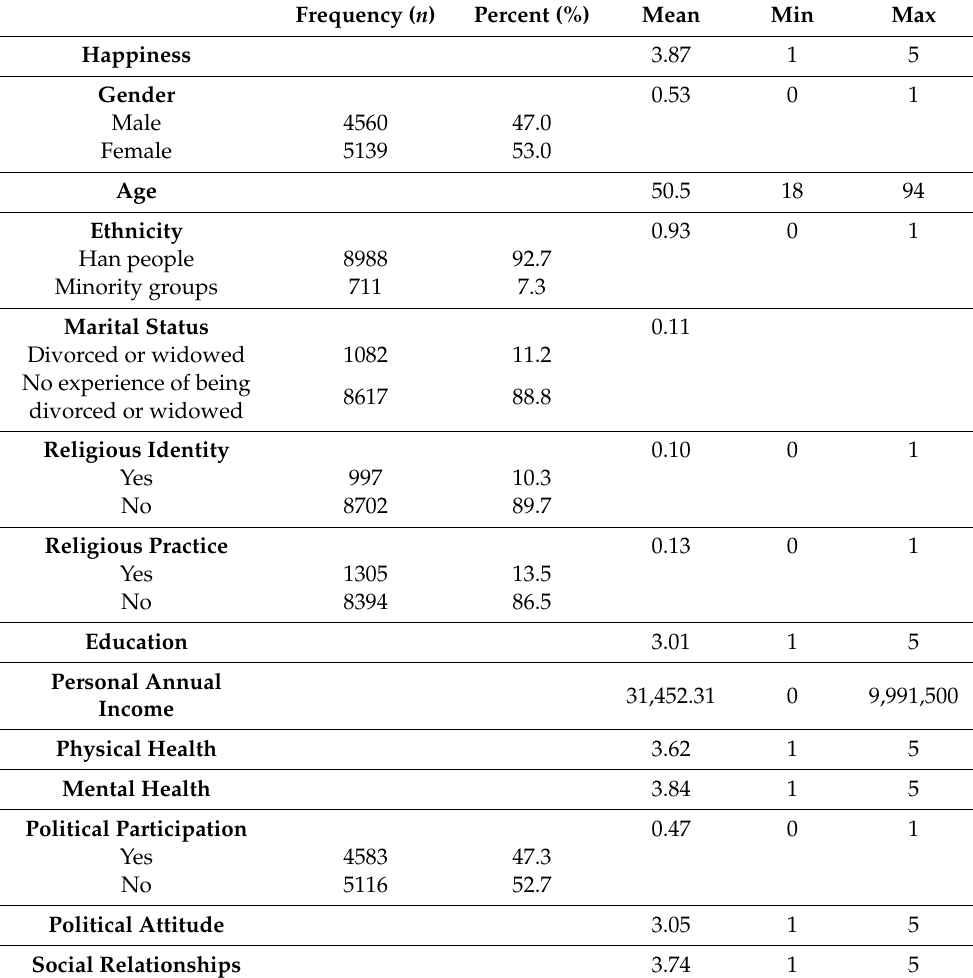
Table 1. Results of Descriptive Analysis ( N =